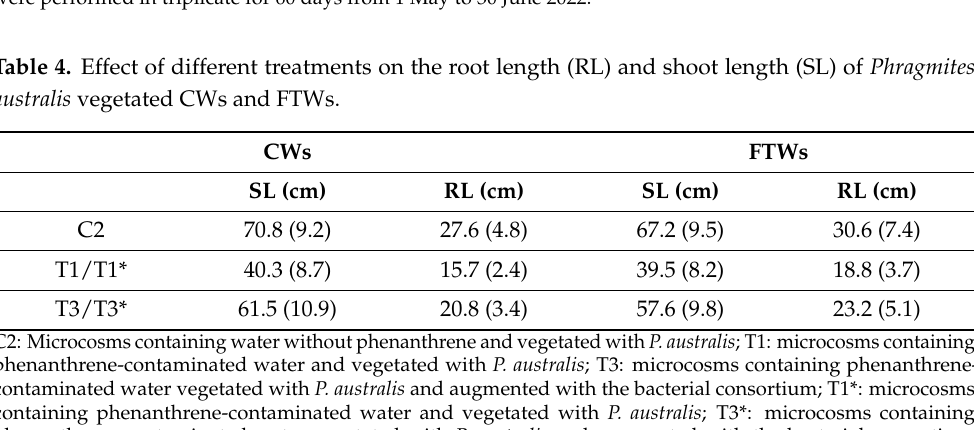
Figure 8. Phragmites australis growth comparison in CWs and FTWs: ( A ) P. australis growth in CWs; ( B ) P. australis growth in FTWs; ( C ) P. australis root growth in CWs; ( D ) P. australis root growth in FTWs.